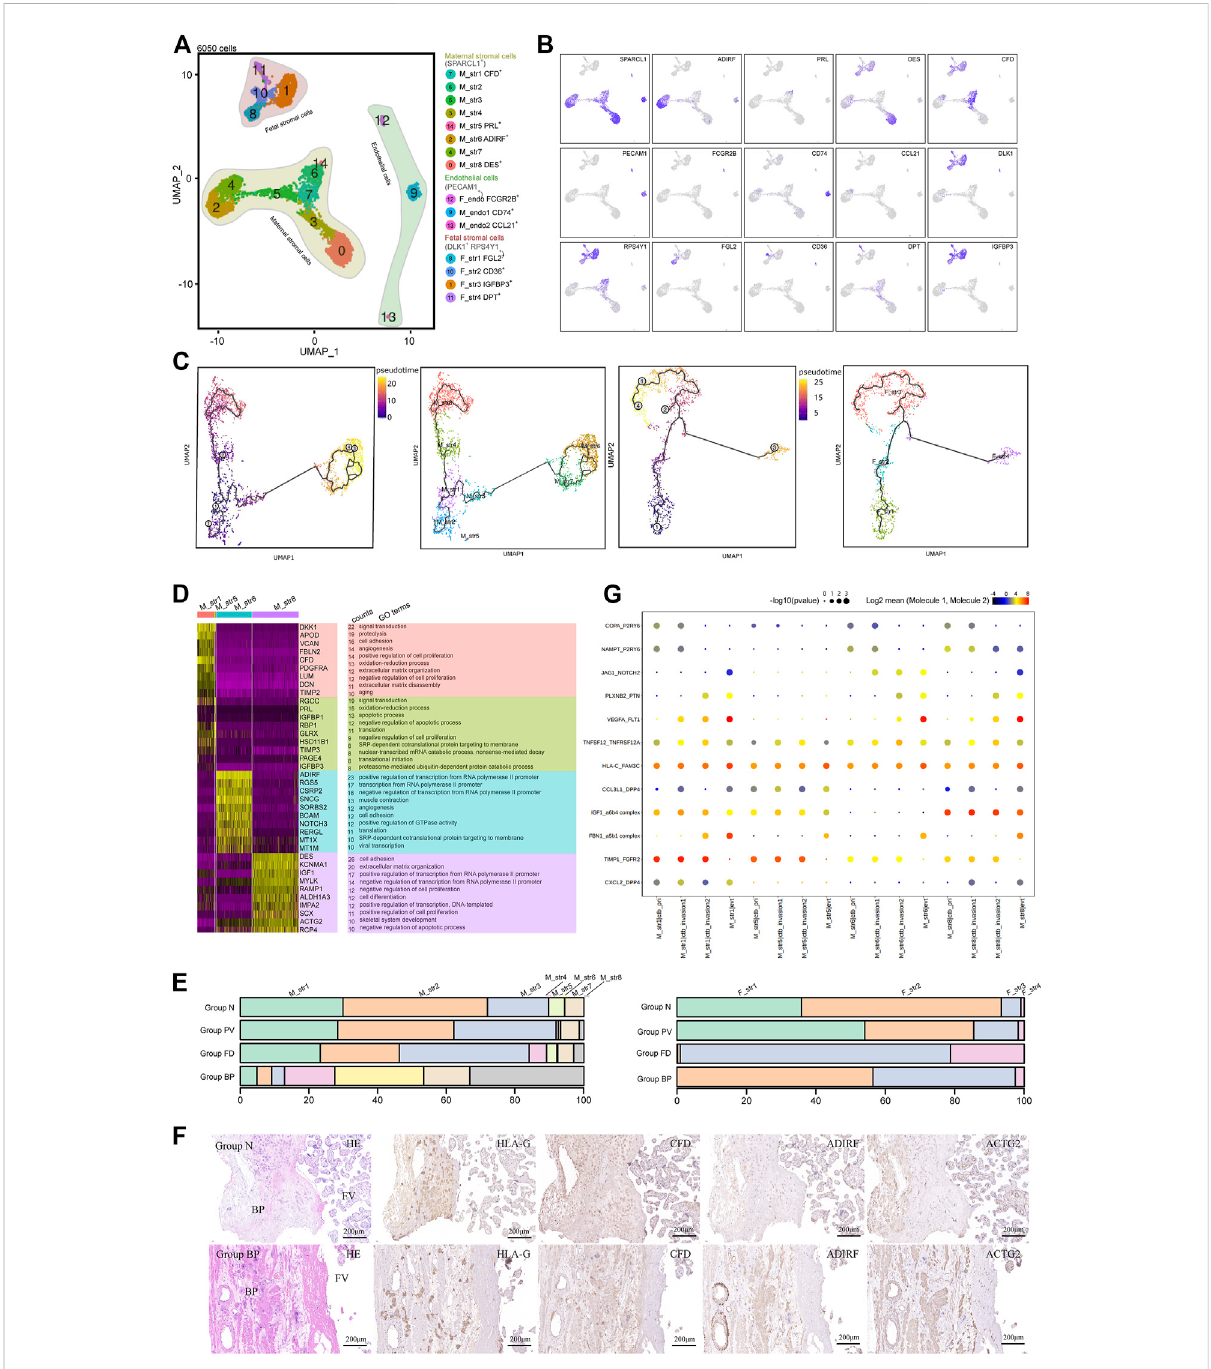
FIGURE 3 Stromal cells that primarily contribute to the trophoblast microenvironment were analyzed with cellular dynamics. (A) UMAP plot showing unbiased subtypes of endothelial cells and maternal and fetal stromal cells for the invasive PAS placenta. (B) UMAP feature plots displaying representativemarkergenesforthestromalcellclustersindicatedinPanel3A. (C) UMAPplotsshowingpseudotimeanalysisofmaternalstromalcells (left panel) and fetal stromal cells (right panel) using Monocle 3. (D) GO analysis for the indicated maternal stromal cell clusters. (E) Stacked bar plot displaying the dynamics of cell types of maternal (left panel) and fetal (right panel) stromal cell clusters by origin. (F) Immunohistochemical staining of tissue from the N and PM groups shows the distribution of maternal stromal cells ( CFD +, ADIRF + and DES +). BP, basal plate; FV, fl oating villi. (G) CellPhoneDB analysis showing the ligand ‒ receptor pairs among maternal stromal cells and